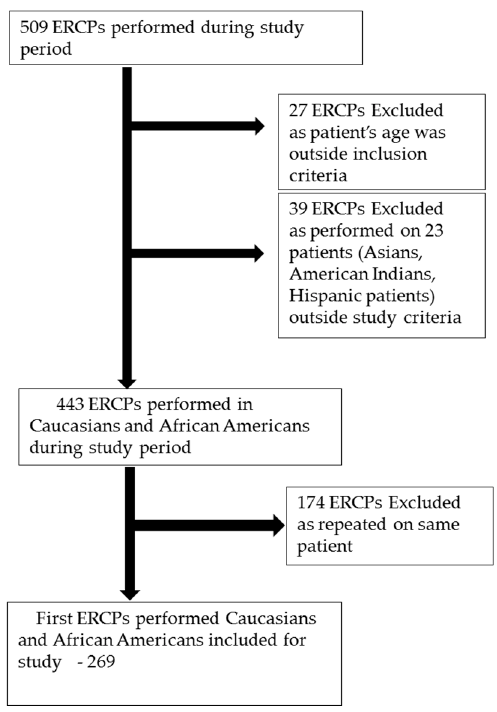
Figure 1. Study patient inclusion/enrollment.